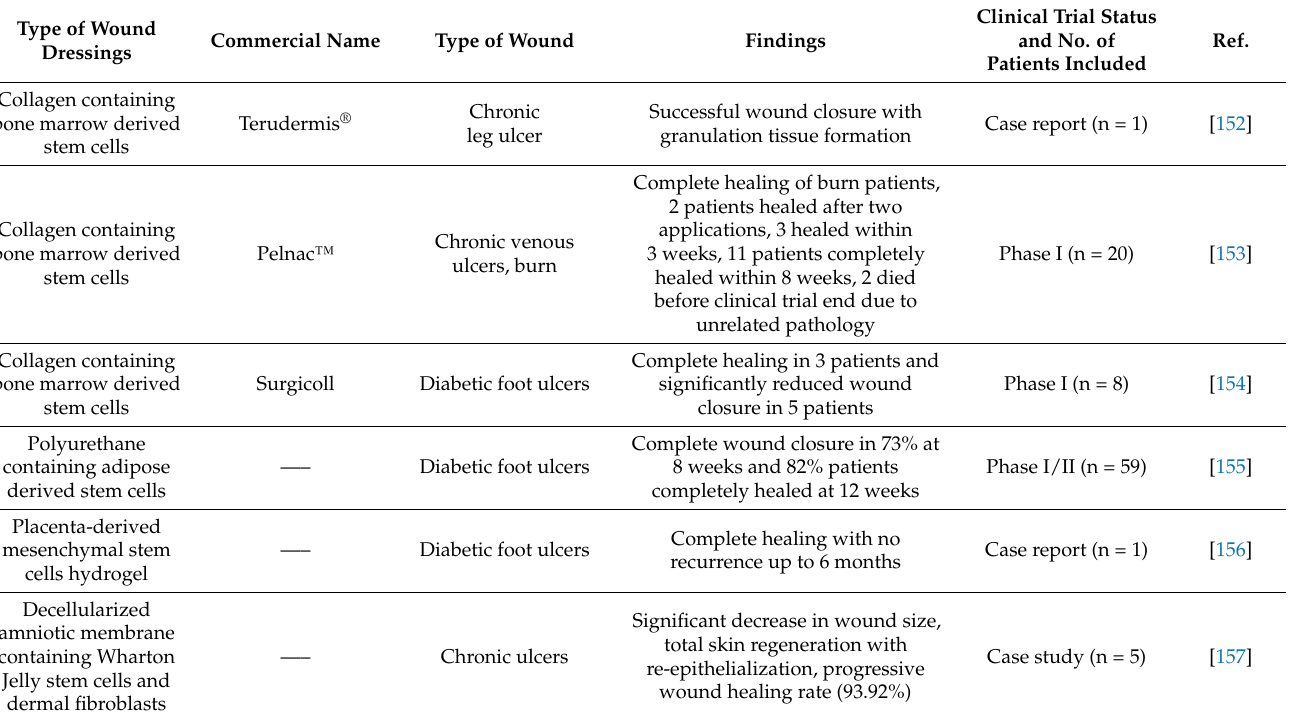
Table 2. A list of clinical and case studies using cell based wound dressings containing mesenchymal stem cells for chronic